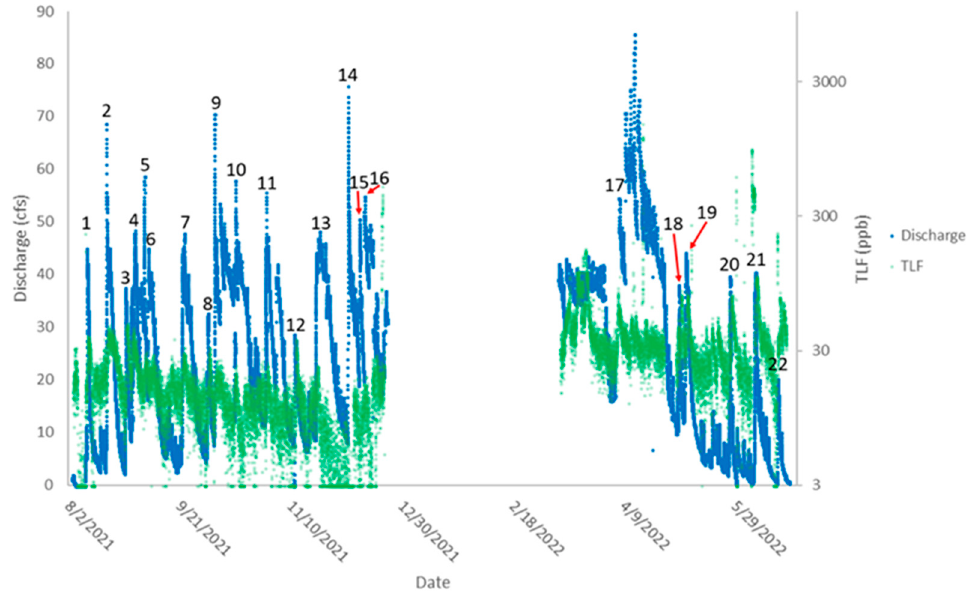
Figure 3. TLF concentrations and discharge during fluorometer deployment at Royal Spring (1.00 cfs = 28.3 L/s). Discharge peaks are indicated by numbers (1–22) corresponding to order of occurrence.